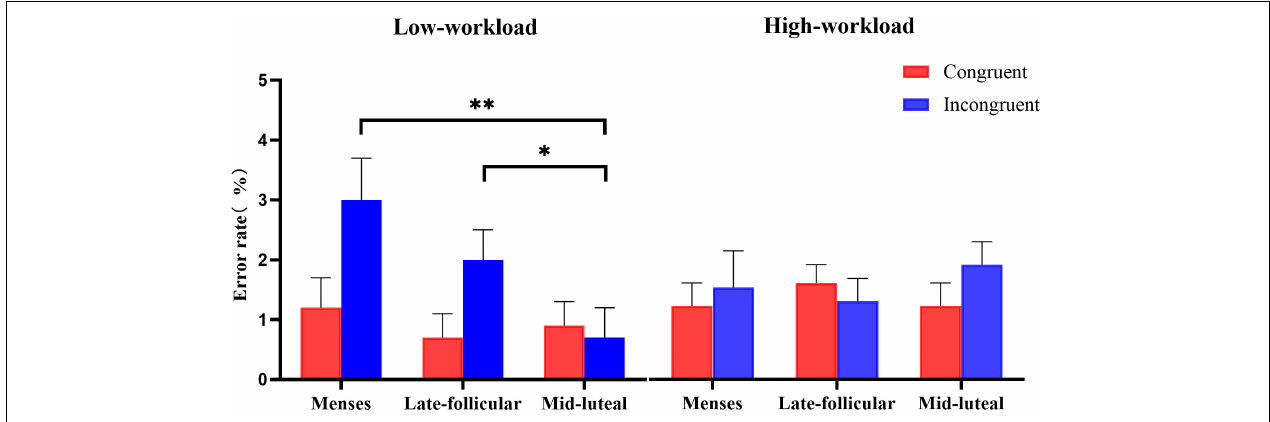
FIGURE 2 | The interactive effect of workload and the menstrual cycle on the error rate measure of the spatial Stroop task. Error bars represent the standard error of the mean. ∗ and ∗∗ indicates p < 0.05 and p < 0.01, correspondingly.